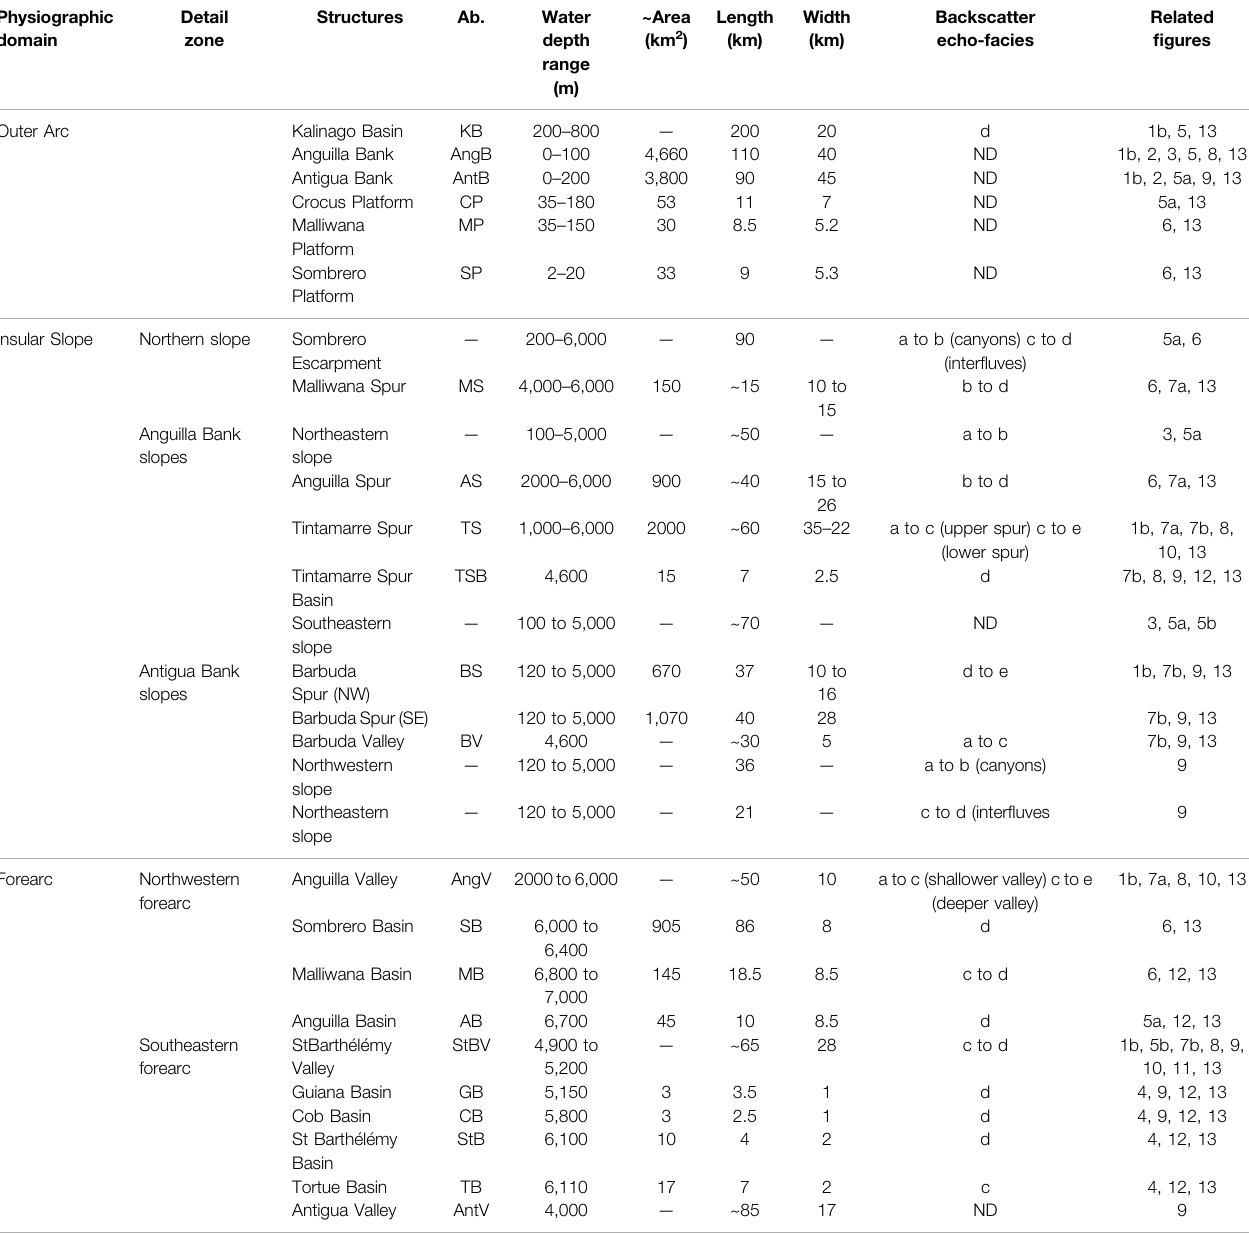
TABLE 1 | Main characteristics of the structures of the Norther Lesser Antilles Segment. Physiographic